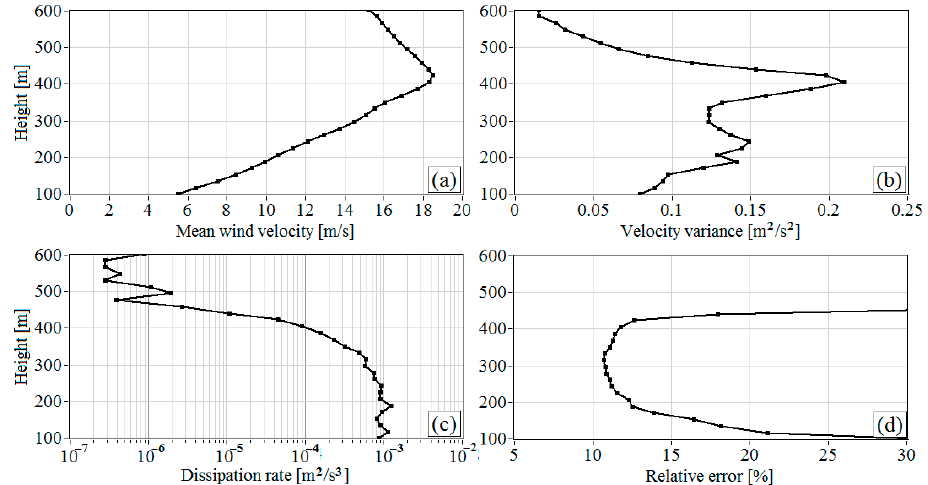
Figure 11. Vertical profiles of the mean wind velocity ( a ), variance of the vertical component of wind velocity vector ( b ), turbulent energy dissipation rate ( c ), and relative error of lidar estimation of the dissipation rate ( d ) as calculated from data of the 2D distribution in Figure 9. Measurements from 03:02 to 03:33 LT on 2 July 2020.